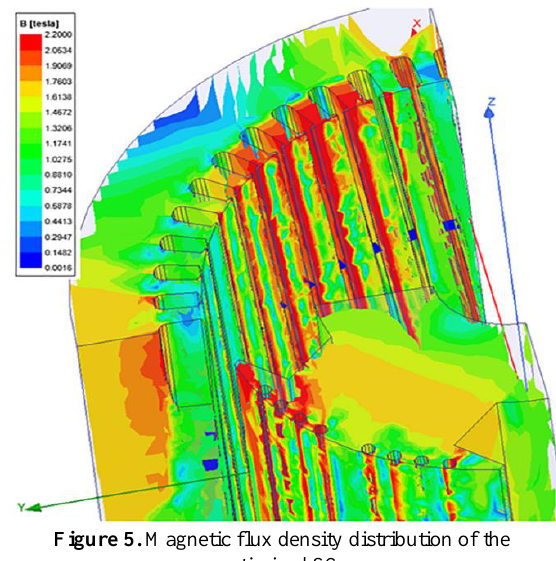
Figure 5. Magnetic flux density distribution of the optimized SG.